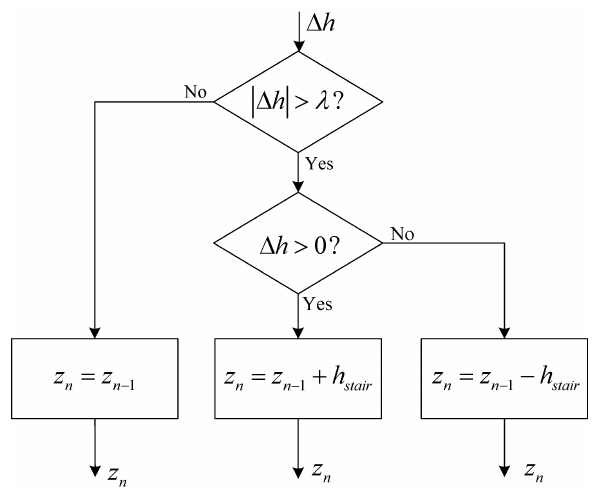
Figure 8. Height calculation in a